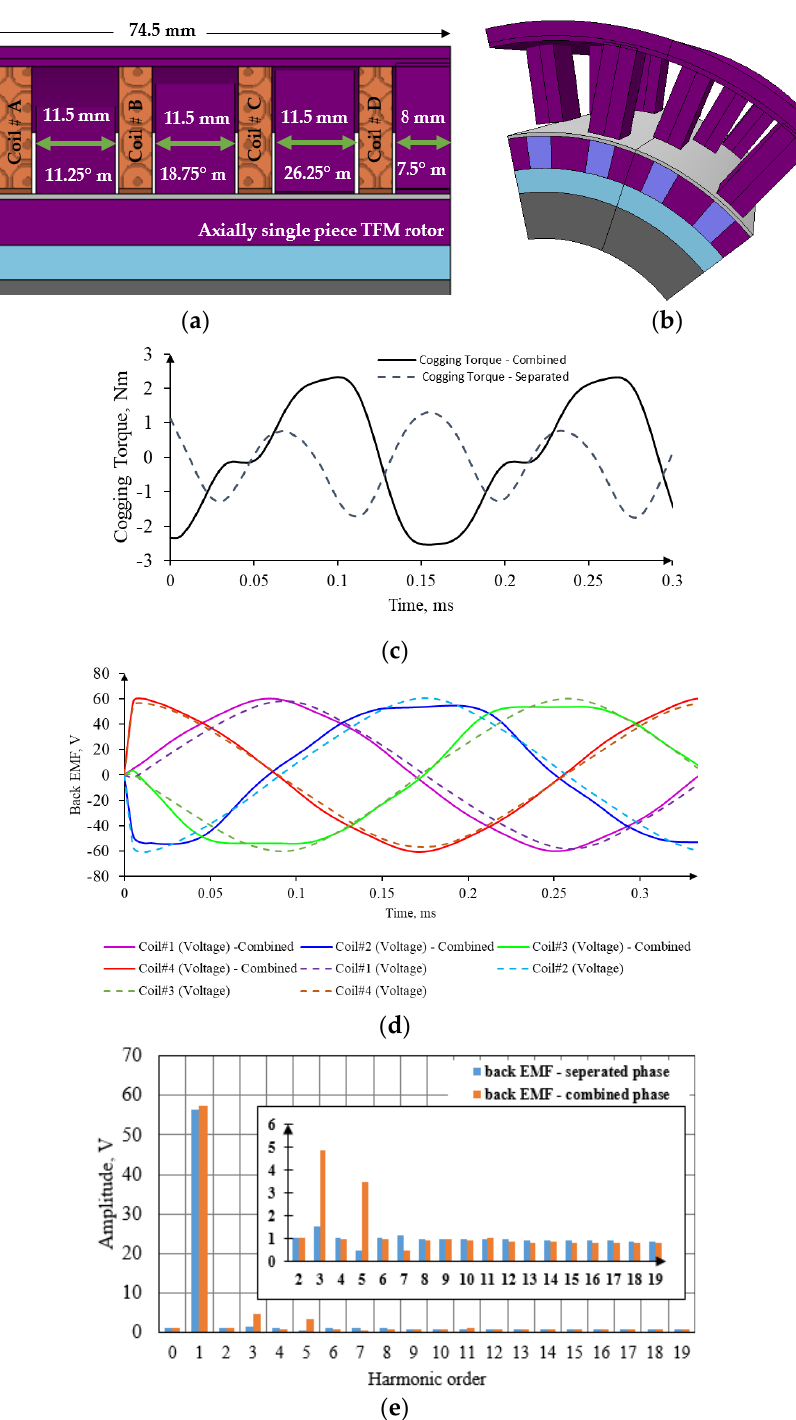
Figure 6. Comparison between separate phases TFM vs. combined phase TFM, ( a ) final geometry with mechanical phase shifts and lengths; ( b ) 3-dimenisonal view of stator teeth for the combined phase TFM; ( c ) open circuit voltage comparison (1/6 of complete model), ( d ) cogging torque com- parison (full model); ( e ) back EMF harmonics comparison (fundamental 3000 Hz)—combined vs. separated